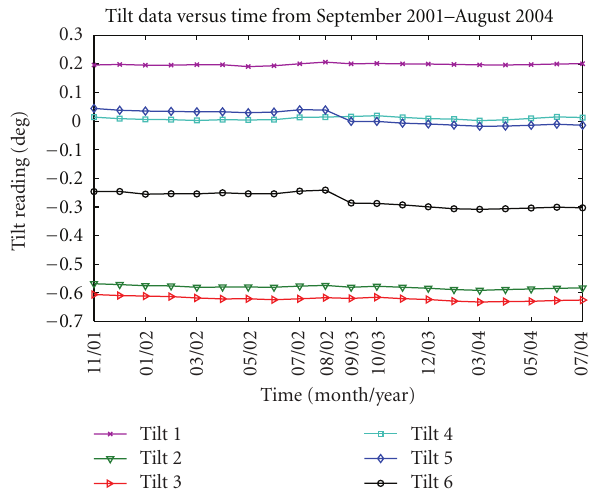
Figure 5: Tilt data versus time from September 2001 to August 2004 for Hartford Flyover